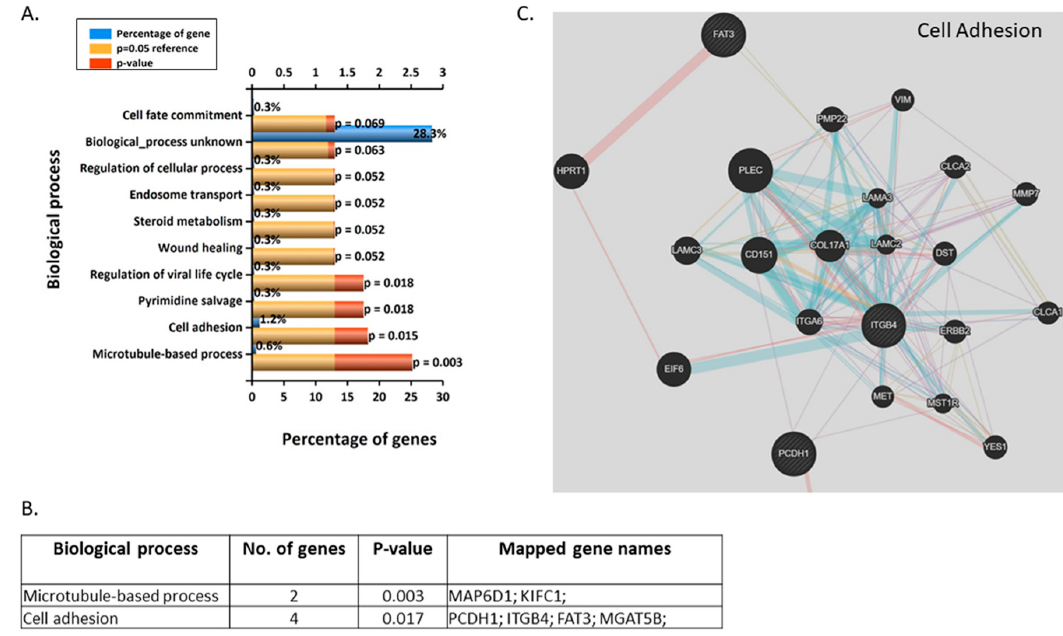
( A ) Top 10 enriched (Funrich) biological processes for 10 nM BPA-treated BeWos. ( B ) Table of genes involved in biological processes: protocadherin 1 (PCDH1), FAT atypical cadherin 3 (FAT3mannosyl (alpha-1,6-)-glycoprotein beta-1,6-N-acetyl-glucosaminyltransferase, isozyme B (MGAT5B). ( C ) Network annotation of genes involved in cell adhesion